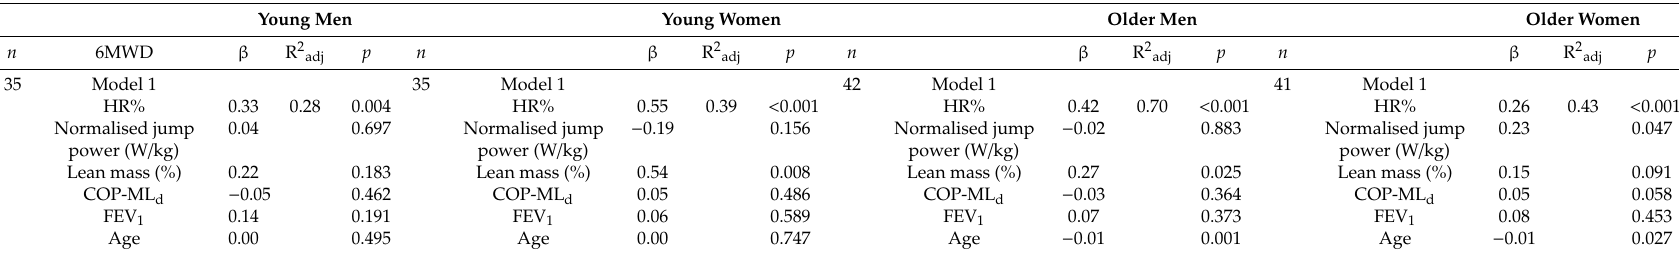
Table 6. Explanatory variables - multivariate regression models stratified by age and sex, with the six-minute walk distance as the dependent variable and body composition and physiological variables as independent